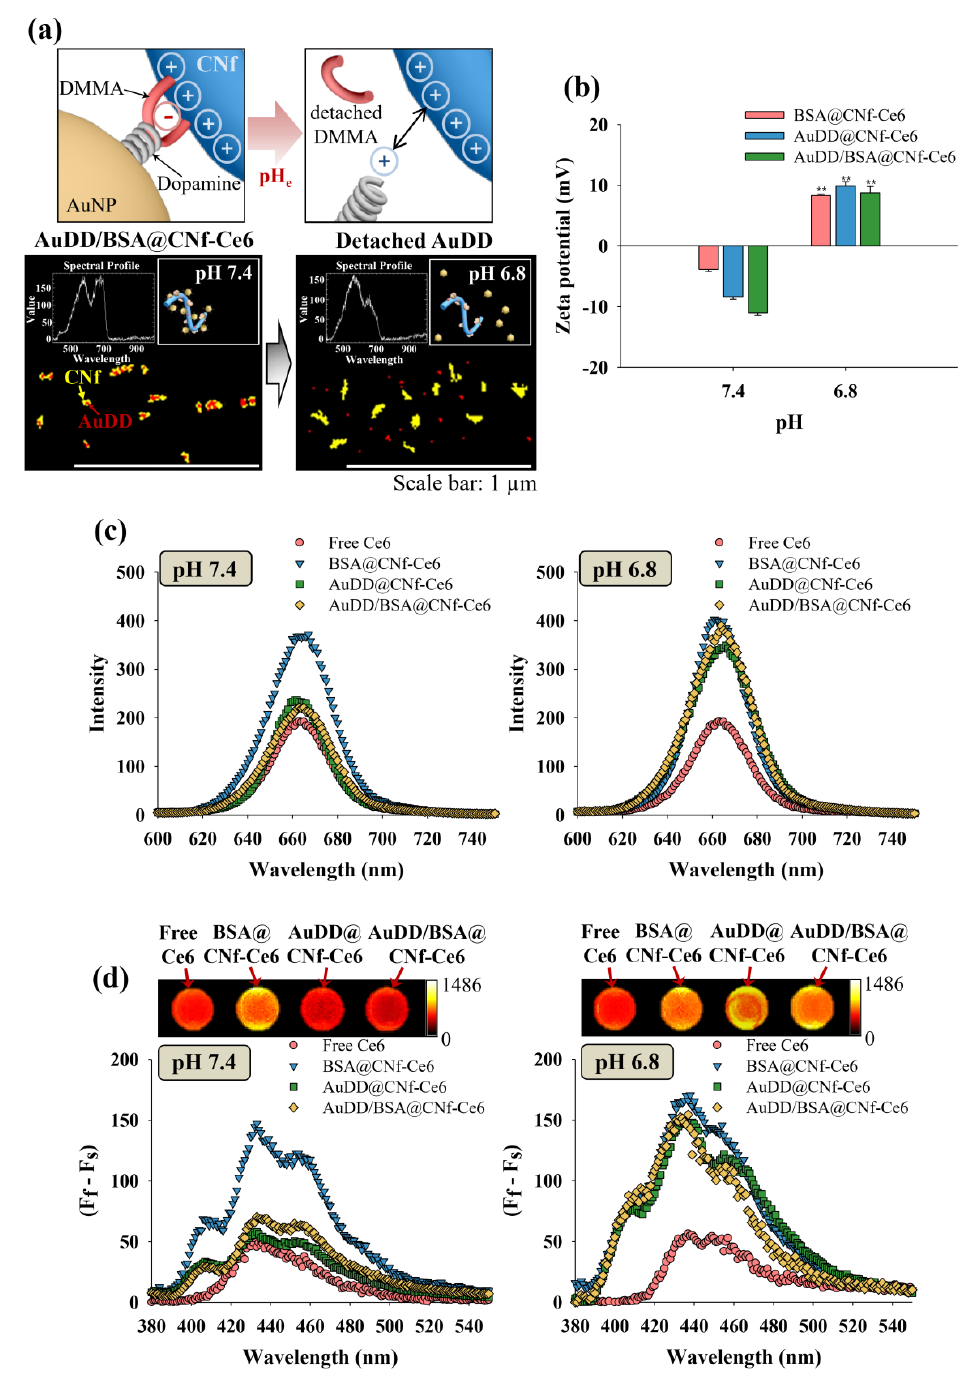
Figure 3. ( a ) Schematic illustration and hyperspectral images of anchored/detached AuDD from the CNf backbone at pH 7.4 and 6.8. ( b ) Changes in zeta potential of CNf-Ce6-based samples at pH 7.4 and 6.8 (mean ± SD, n = 3, ** p < 0.01 compared to pH 7.4). ( c ) Ce6 emission spectra ( λ ex = 400 nm, λ em = 600–750 nm) for the free Ce6 or CNf-Ce6-based samples at pH 7.4 and 6.8. ( d ) 9,10-Dimethylanthracene fluorescence change (F f –F s ) in free Ce6 or CNf-Ce6-based samples at pH 7.4 and 6.8 (lower graphs), and NIR Ce6 fluorescence ( λ ex = 635 nm, λ em = 720 nm) images of free Ce6 or CNf-Ce6-based samples at pH 7.4 and 6.8 (upper images). All samples were irradiated for 10 min at a light intensity of 5.2 mW / cm 2 using a 670 nm laser